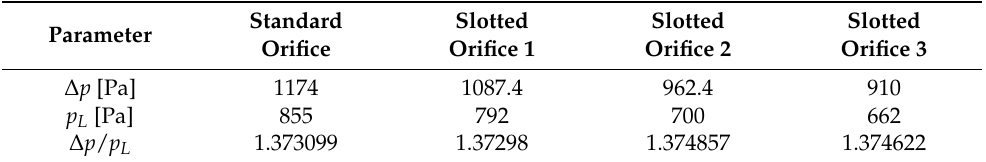
Table 1. Comparison of metrological parameters of investigated orifices for dry air flow rate of Q = 0.045 kg/s.